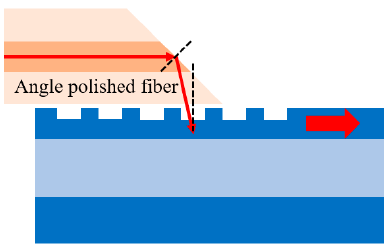
Figure 11. Lateral coupling by angle polished fiber.